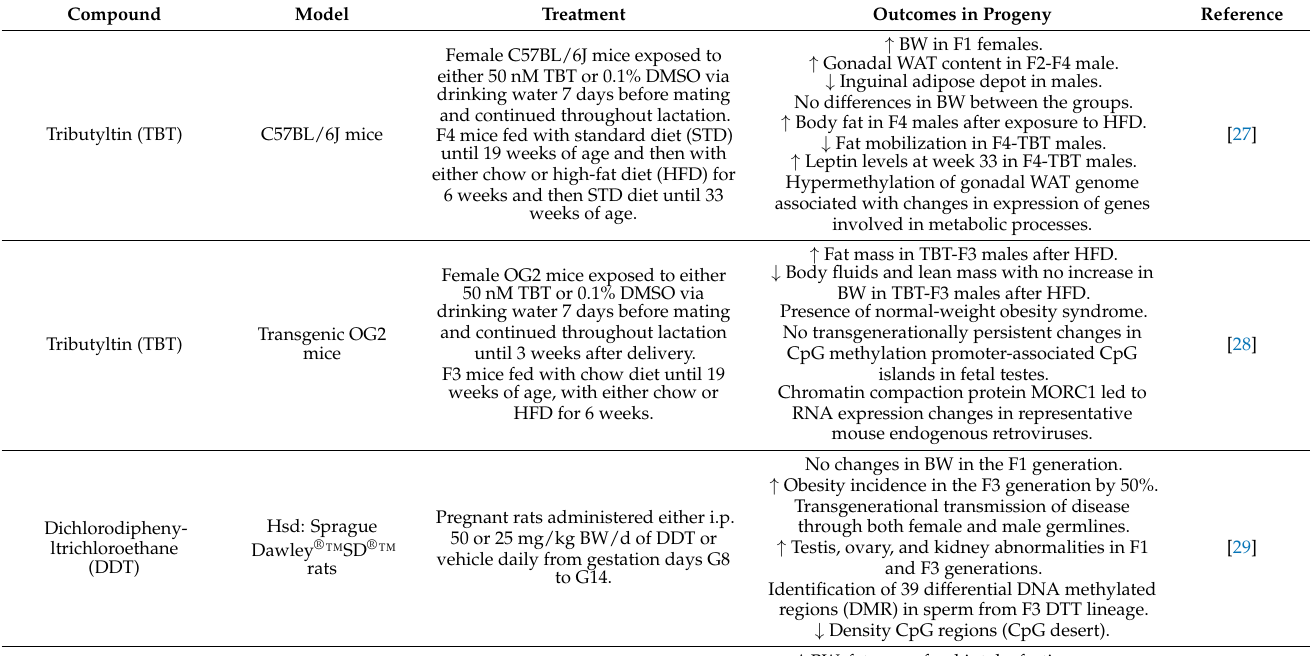
Table 2. Animal studies on transgenerational inheritance of obesity epiphenotypes after ancestral exposure to obesogenic persistent